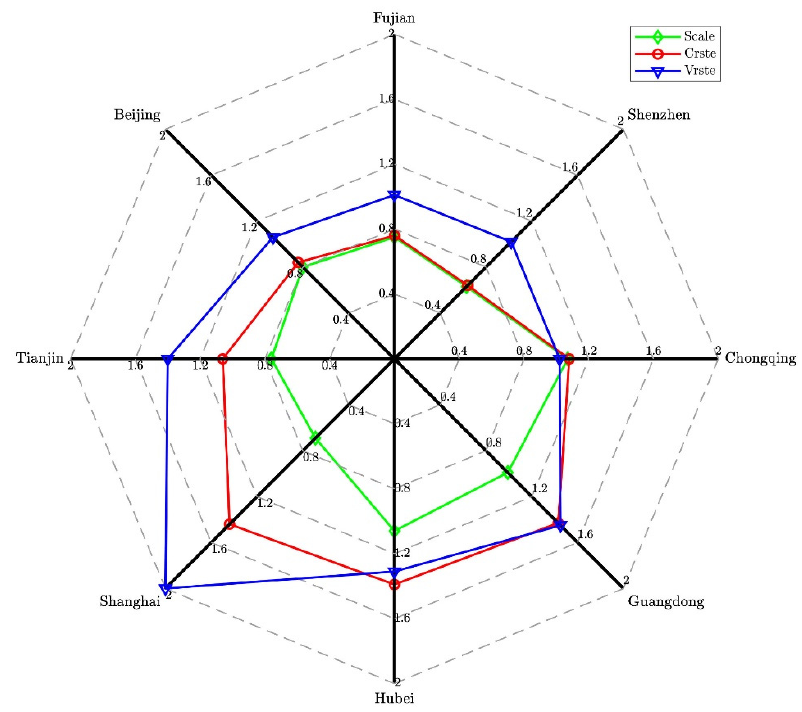
Figure 4. DEA efficiency measurement of the carbon market in 2018.